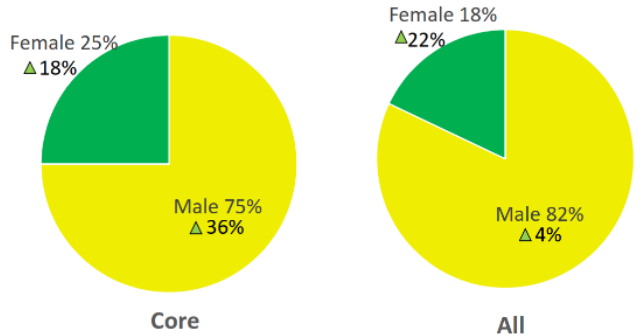
Figure 2. Gender distribution in UWAFT.